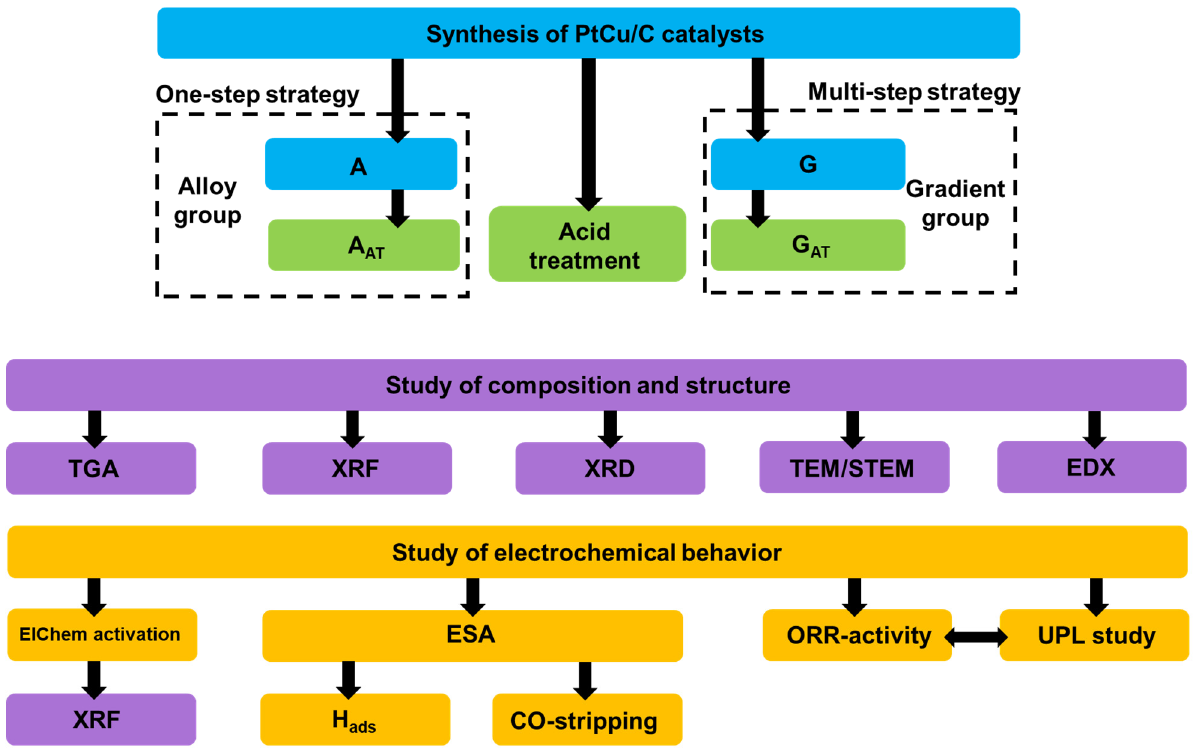
Figure 1. The scheme of research stages.